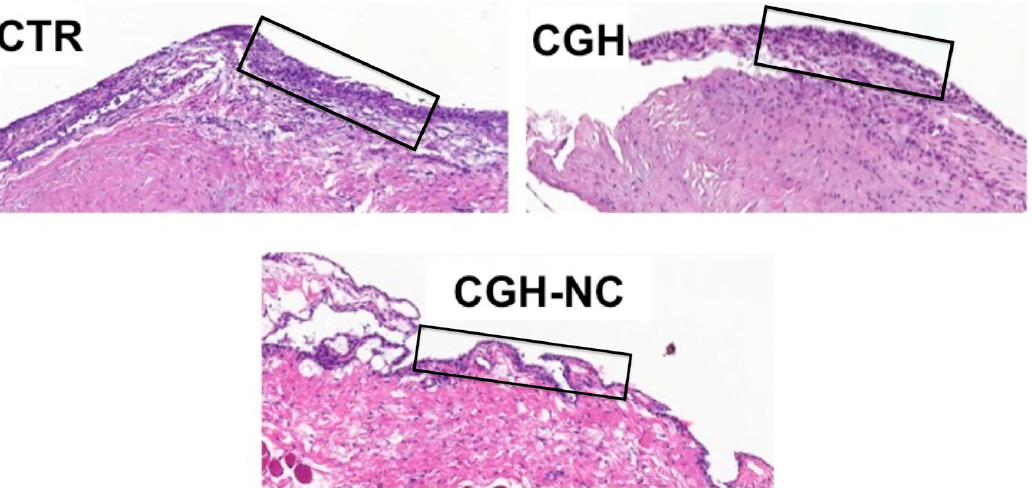
Figure 7. Synovial membrane histologic sections representative of each treatment group 84 days after surgery. Images from the CGH-NC group show a less hyperplastic appearance with only 2–3 synoviocyte layers, unlike the remaining groups. The black box shows the layers of sinoviocytes for each group.